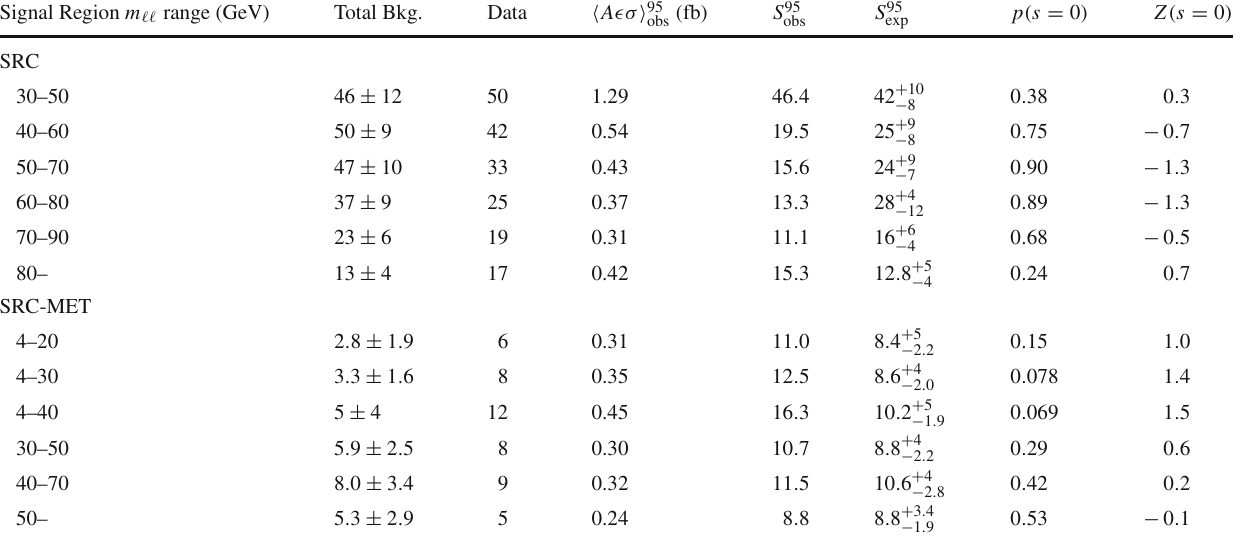
Table 8 Breakdown of the expected background and observed data yields in the low- p T signal regions. The results are given for SRC and SRC-MET in all 12 m (cid:4)(cid:4) windows. The m (cid:4)(cid:4) range in units of GeV is indicated in the left-most column of the table. Left to right: the total expected background, with combined statistical and systematic uncer- tainties, observed data, 95% CL upper limits on the visible cross section Signal Region m (cid:4)(cid:4) range (GeV) Total